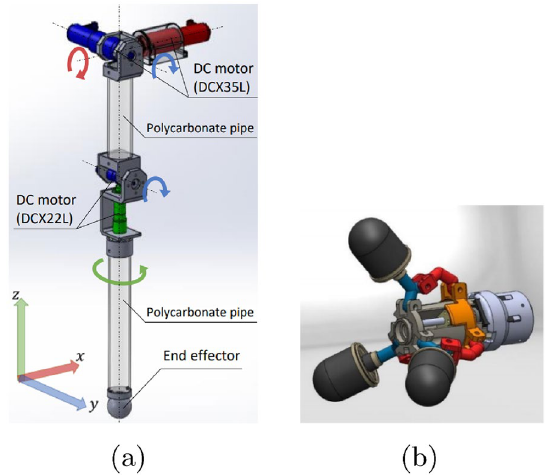
Fig. 12 Robot Arm used for experiments. a Arm details and specificities. b End effector used in